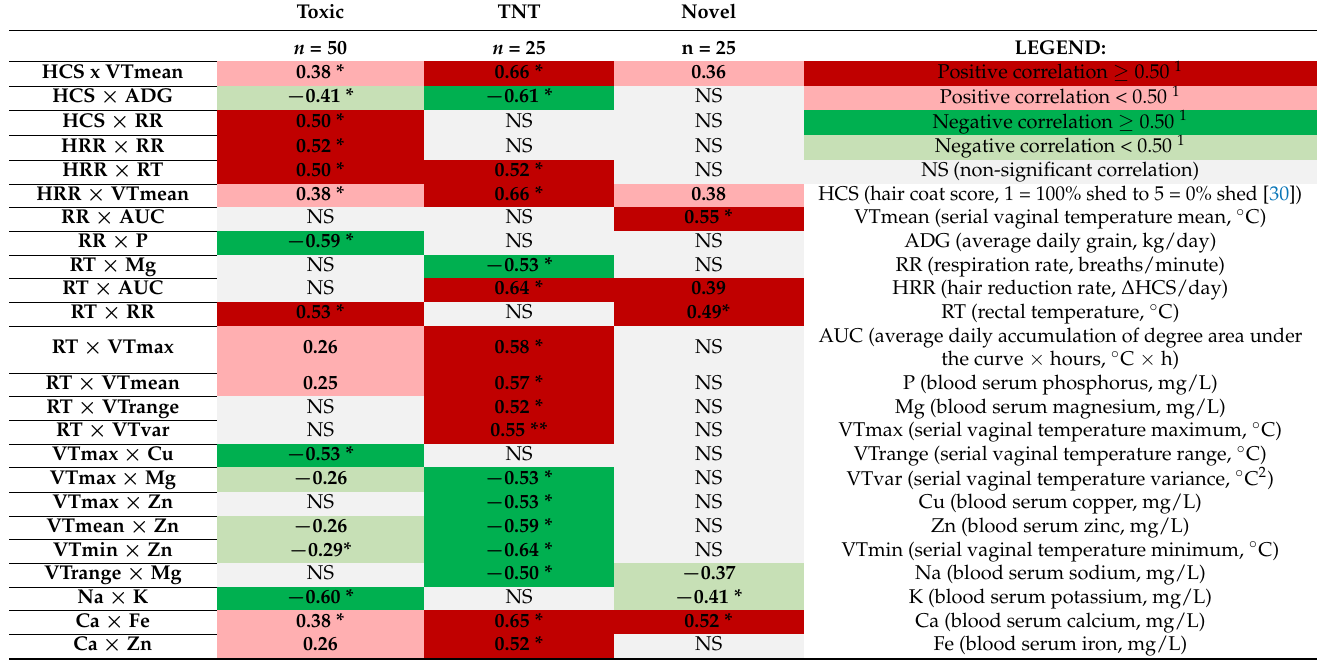
1 all correlations show are p ≤ 0.10 with significant correlations indicated at * p ≤ 0.05. 2 the coloring with the table differentiates highly positively correlated (red; r > 0.5), positively correlated (pink; 0.25 < r < 0.50) from negatively correlated (light green; − 0.5 < r < − 0.25) from highly negatively correlated (dark green; r > − 0.5). Bold indicate statistical